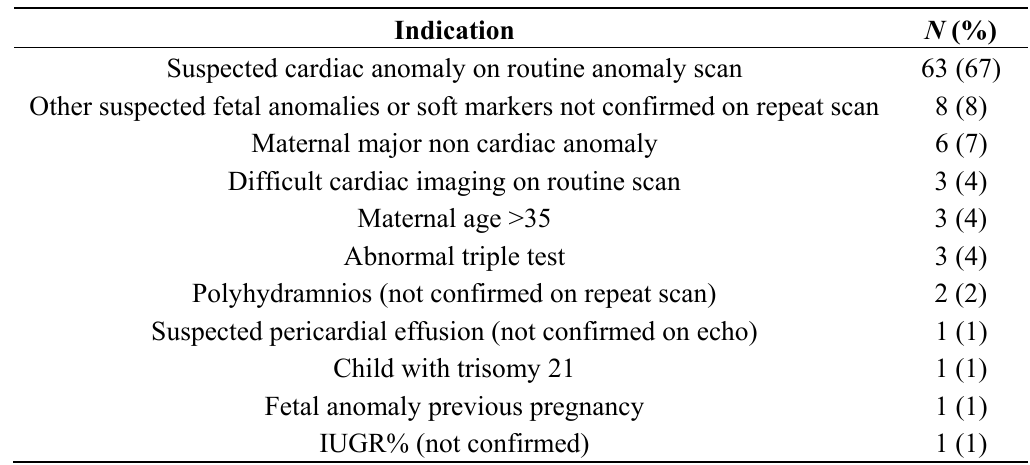
Table 1. Indications for fetal echocardiogram in study